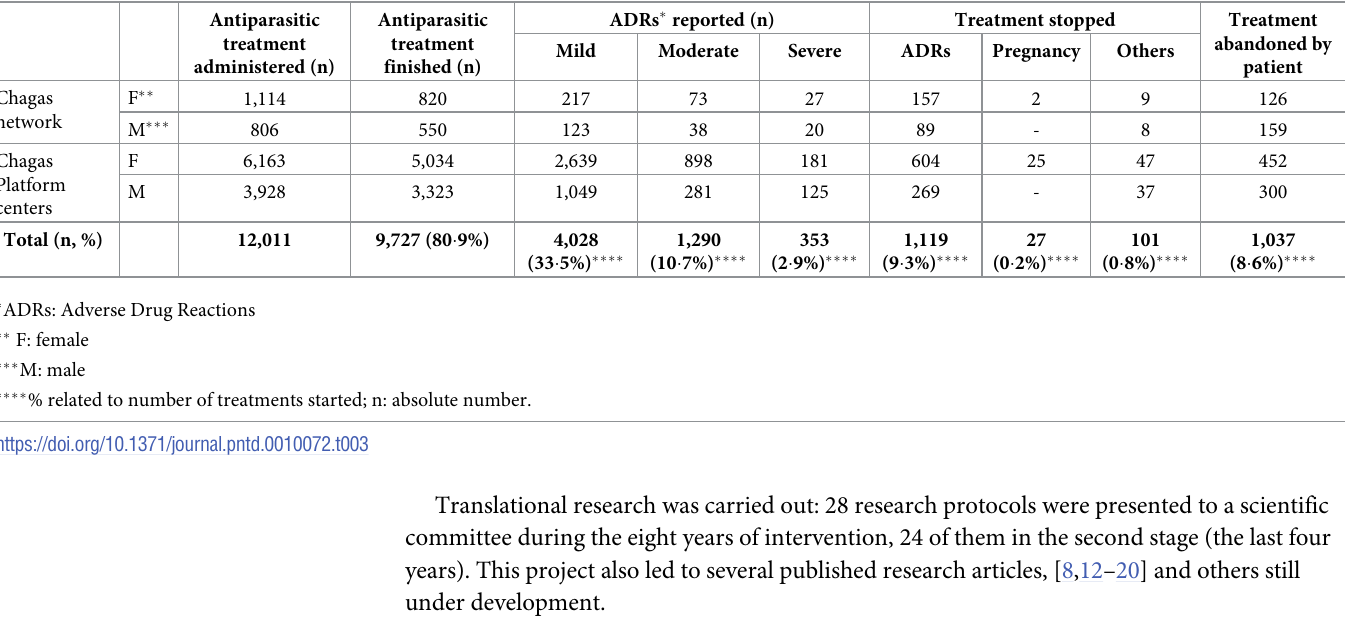
Table 3. Antiparasitic treatment outcomes and benznidazol/nifurtimox tolerability description, in Chagas Platforms centers and Chagas network (2010-06/2018).